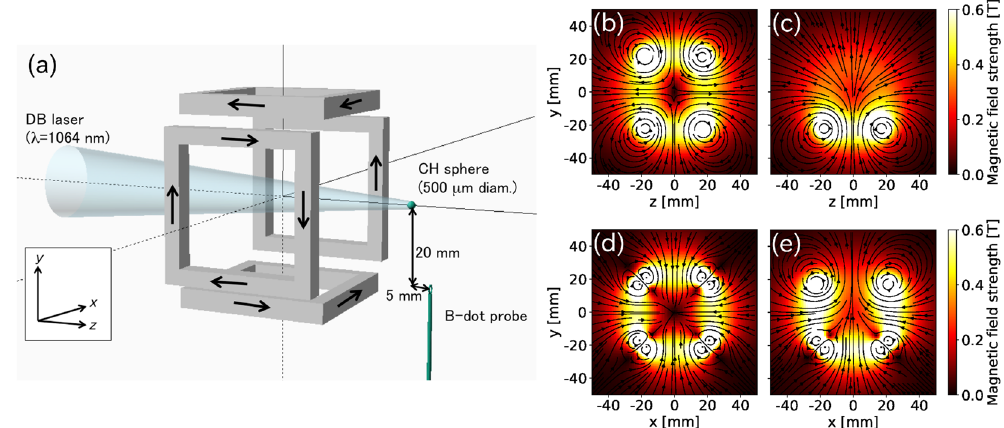
Figure 1. ( a ) A multiple-coil system with four rectangular coils and the experimental setup. A B-dot probe was placed below a spherical target and the target was irradiated with a pulsed laser through the coil. The magnetic field structure used in the experiment on the plane x = 0 with ( b ) four and ( c ) three coils, and on the plane z = 0 with ( d ) four and ( e ) three